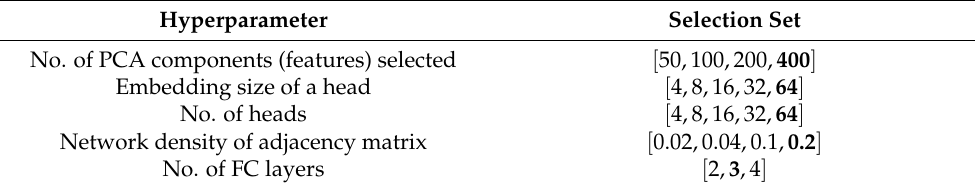
Table 2. Hyperparameter selection for omicsGAT Clustering. The bolded values are used as defaults.